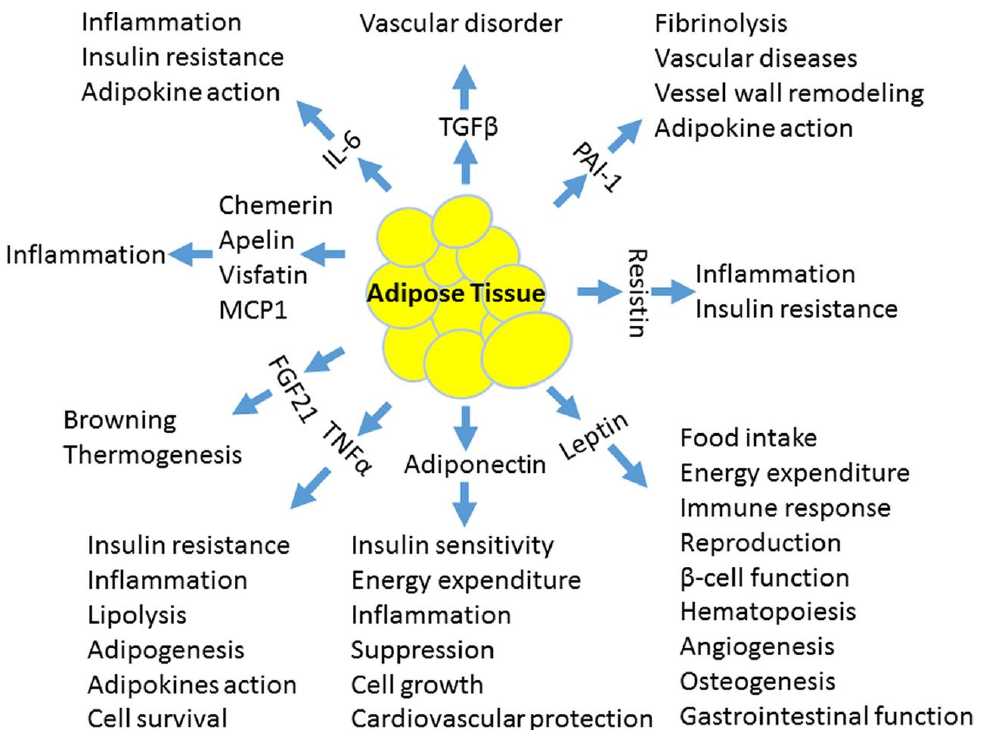
Figure 1. Several highly active molecules are released from adipocytes and affect vascular endothelial function by modulating the balance between nitric oxide synthesis and reactive oxygen radicals. Adapted by Luo et al. [15]. PAI-1, plasminogen activator inhibitor-1; MCP-1, monocyte chemoattractant protein-1; IL-6, interleukin-6; TNF-alpha, tumor necrosis factor-alpha; FGF21, fibroblast growth factor 21; TGF-beta, transforming growth factor beta.